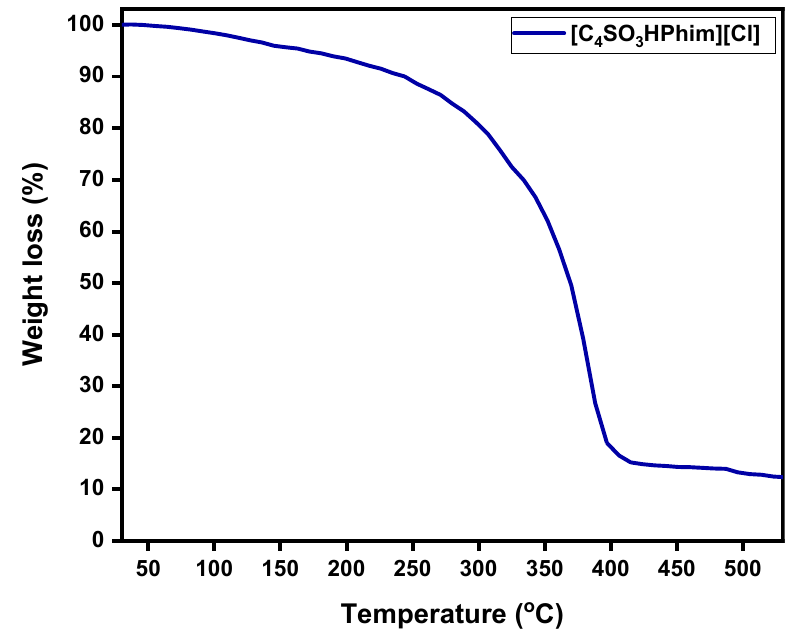
Figure 2. TGA of the synthesized ionic liquid catalyst ([C 4 SO 3 HPhim][Cl]).